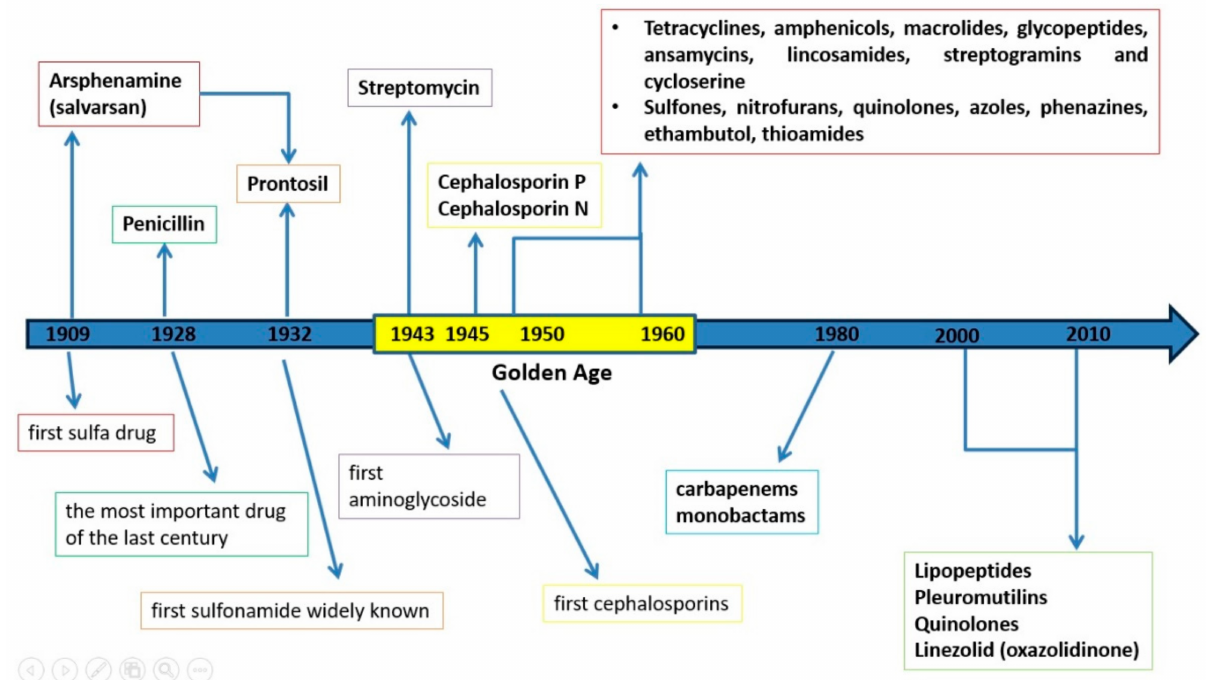
Figure 1. The evolution of